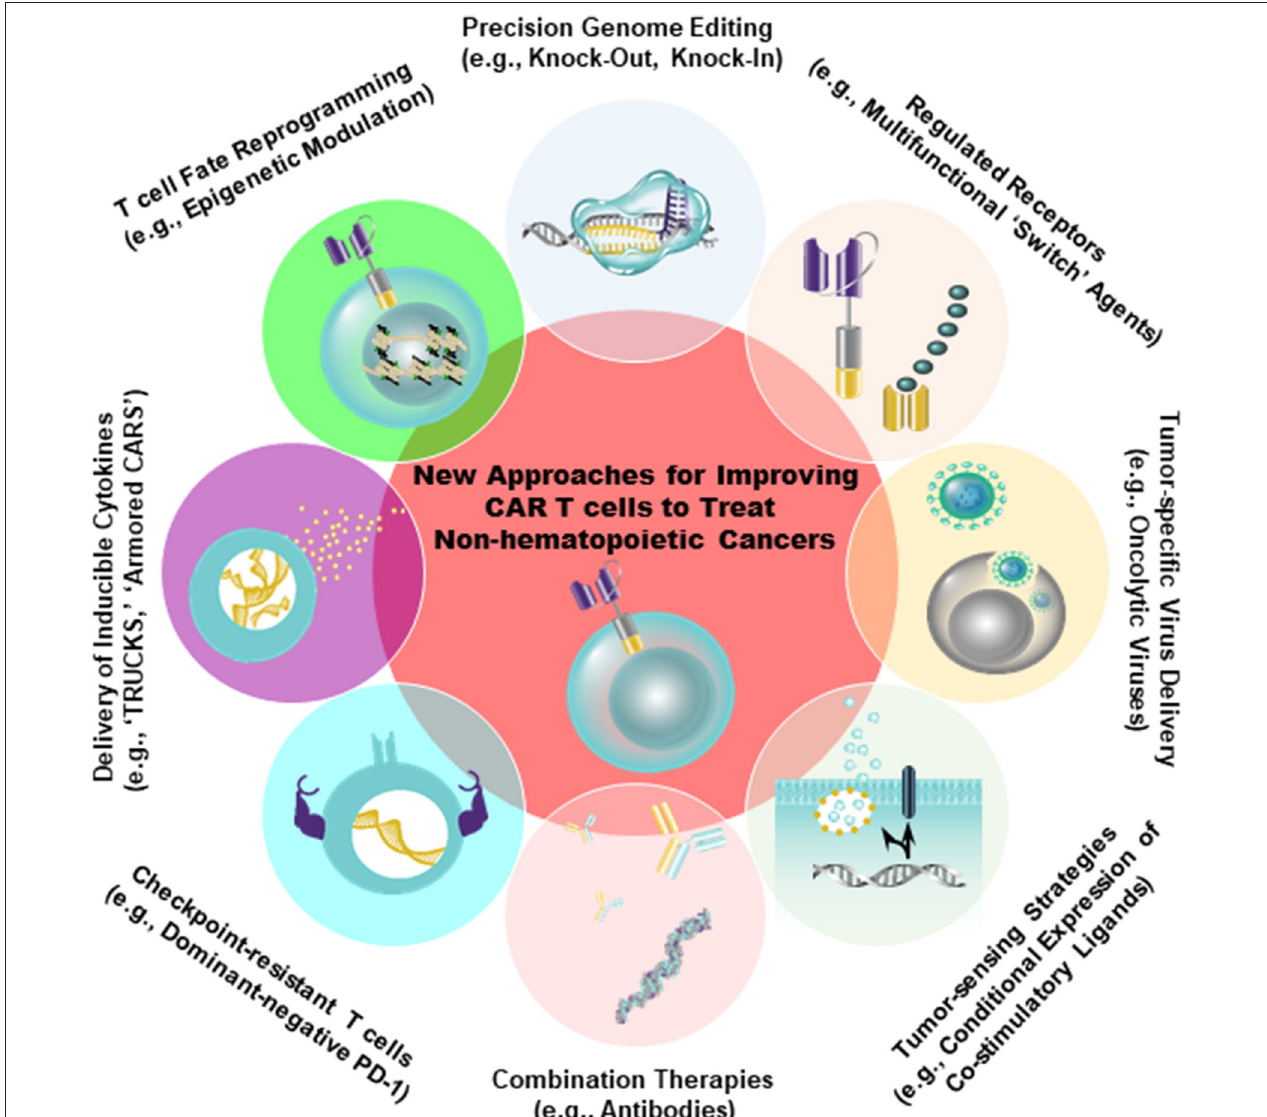
FIGURE 2 | Strategies to improve the safety (e.g., tumor-sensing strategies) as well as to augment the anti-tumor efficacy of CAR T cells are shown. Genetic engineering can be accomplished using viral (e.g., lentiviruses, retroviruses) and non-viral (e.g., CRISPR/Cas9) approaches to endow CAR T cells with gain-of-function or loss-of-function alterations. The overall aim of these approaches is to improve intrinsic T cell fitness and allow these cells to elicit optimal effector activity in the setting of several extrinsic barriers operative within solid tumors, as shown in Figure 1